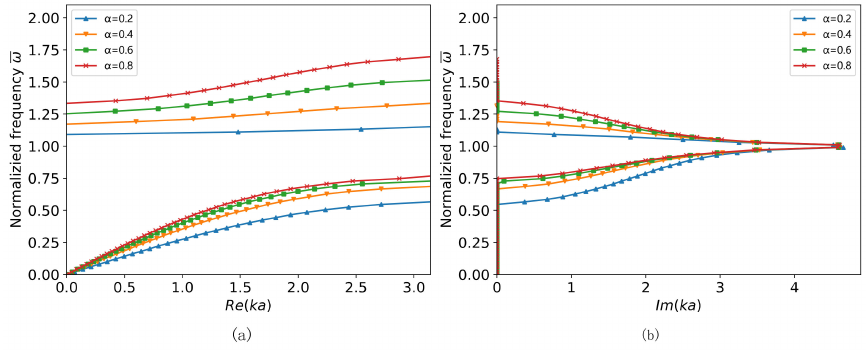
Figure 4. Dispersion relation for the linear EMs with β = 2 and different mass ratio.